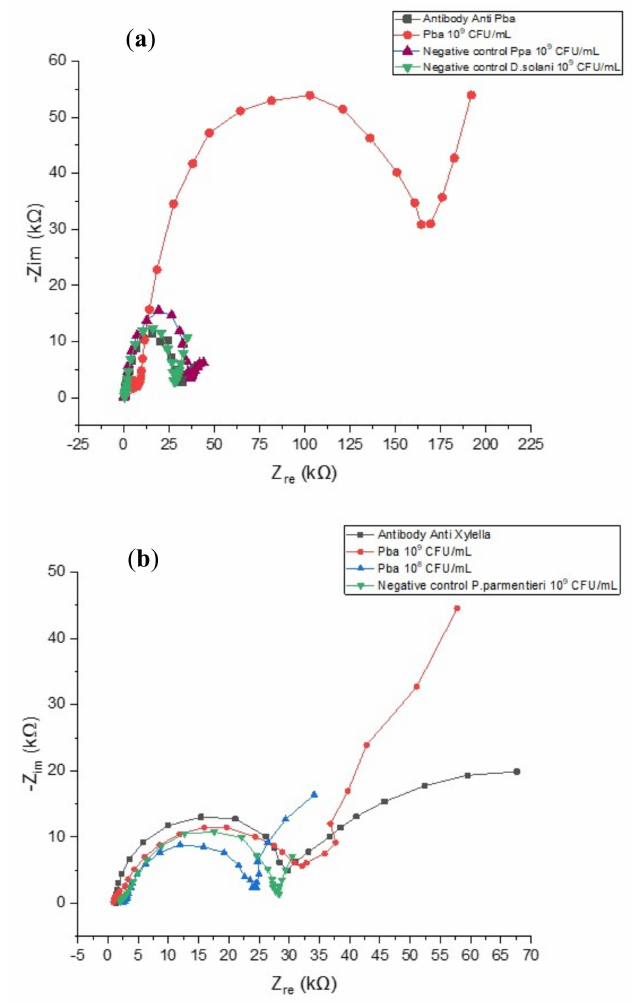
Figure 5. ( a ) Nyquist spectra obtained during negative testing with P. parmentieri and Dickeya solani at 10 9 CFU / mL and positive control ( Pectobacterium atrosepticum 10 9 CFU / mL). ( b ) Nyquist spectra obtained by testing of P. atrosepticum , P. parmentieri and D. solani on a chip functionalized with antibodies anti- Xyllella. fastidiosa